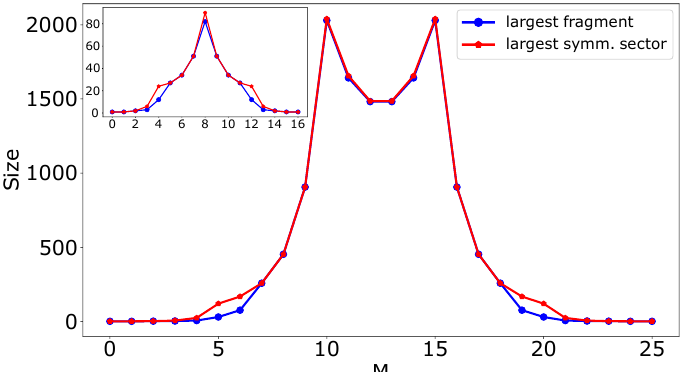
Figure 8: (Blue) the size of the largest fragment in each M -sector; (Red) the size of the largest symmetry sector in each M -sector, for the Hamiltonian ˆ H (1 × 1 interaction range) on the 5 × 5 lattice with p.b.c. Inset: same for the 4 × 4 lattice with